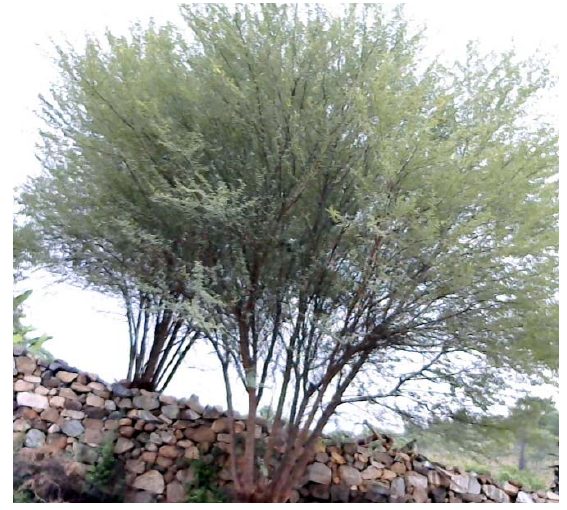
Figure 1. Acacia nilotica .